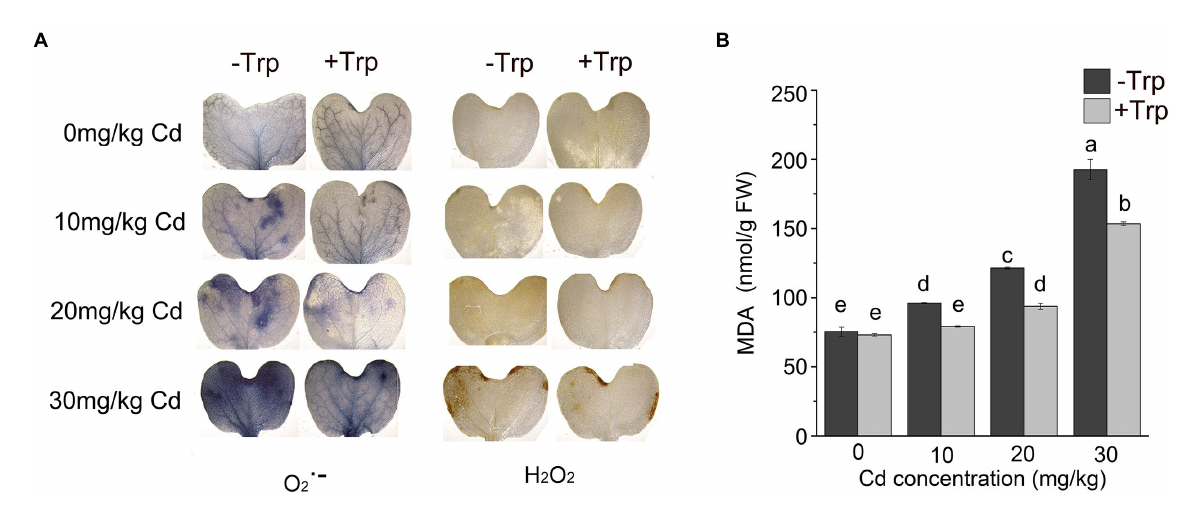
FIGURE 2 Effect of Trp on Cd induced reactive oxygen production and lipid peroxidation. (A) Histochemical detection of H 2 O 2 and O 2• − . (B) MDA content. Data were averaged from three independent replicates ± SD. Different letters represent significant differences between different treatments ( p ≤ 0.05). FW, fresh weight.